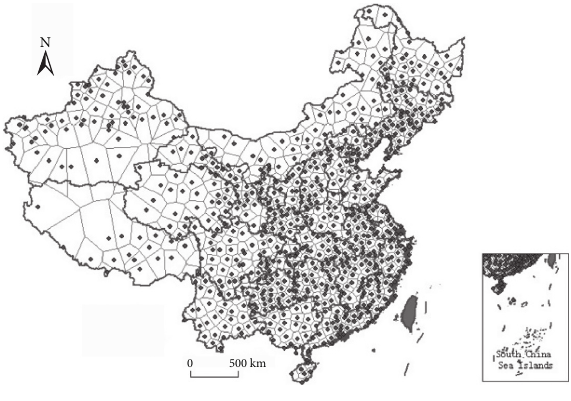
Figure 1: Thiessen polygon division of the NRCS and NBMOS in mainland China